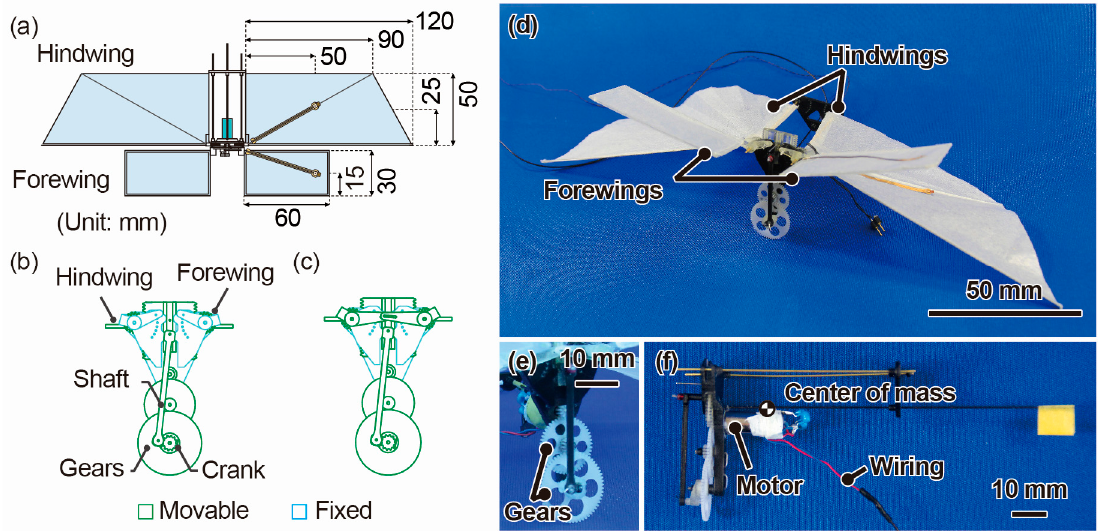
Figure 1. ( a ) Design of the beetle-type ornithopter with the micro-electro-mechanical systems (MEMS) differential pressure sensors on the forewing and hindwing; ( b , c ) crank mechanisms of the ornithopter with a fixed forewing and flapping forewing; ( d ) photograph of the fabricated ornithopter; ( e ) close-up view of the crank mechanism; ( f ) side view of the frame without forewings. Table 1. Characteristics of a beetle and the developed ornithopter.